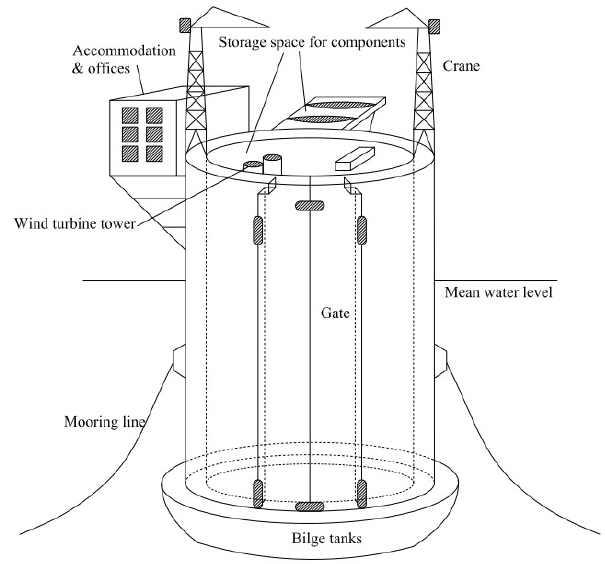
Figure 11. Floating dock concept (Jiang et al.,